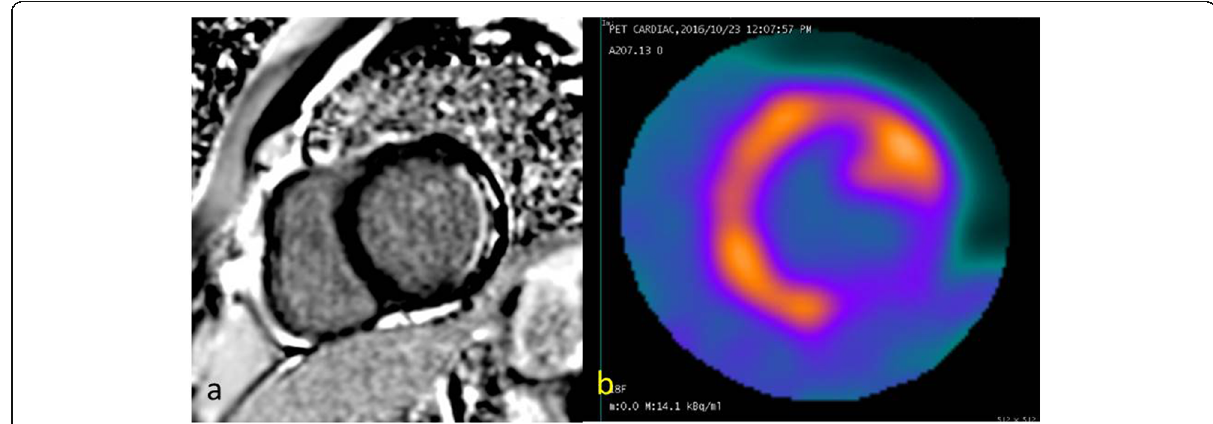
Fig. 2 A 60-year-old male with triple vessel disease. a Free-breathing delayed contrast-enhanced MRI in short-axis view reveals late gadolinium enhancement in < 50% myocardial thickness suggestive of subendocardial infarct in the left circumflex artery territory. b 18 F-FDG PET reveals normal uptake in the left anterior descending artery and right coronary artery territory and reduced uptake in left circumflex